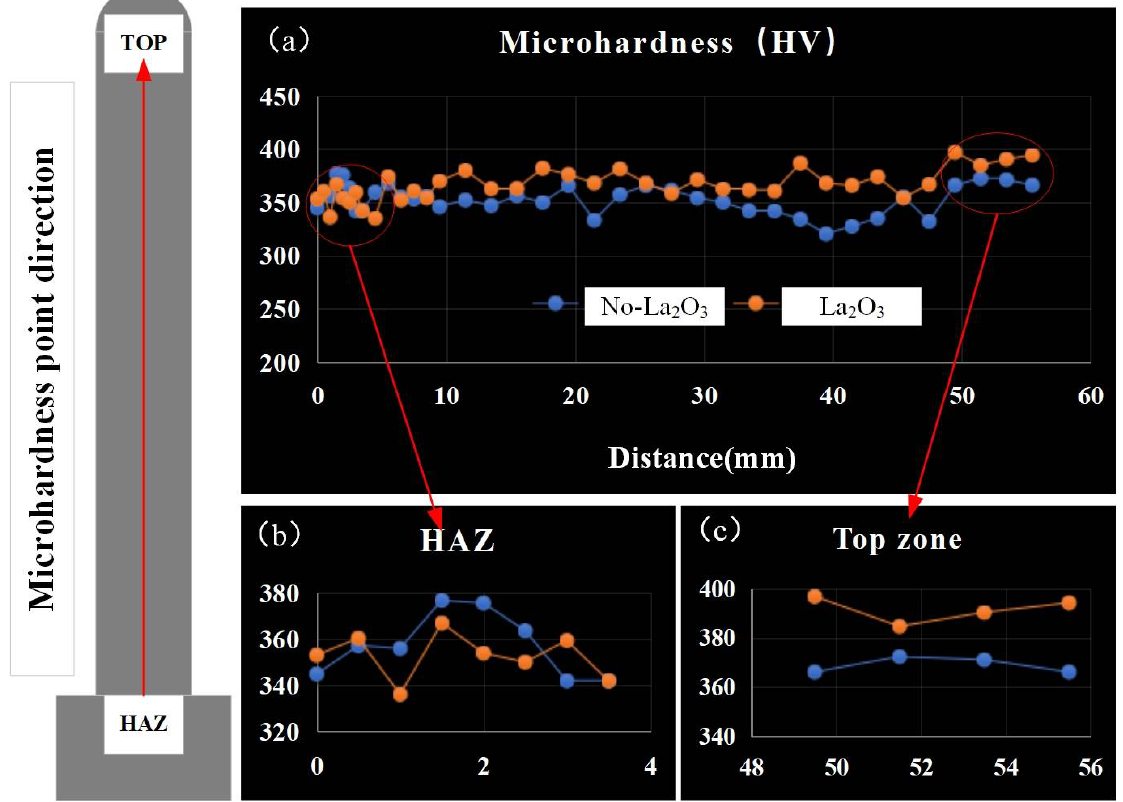
Figure 8. Microhardness distribution. ( a ) the microhardness of thin-walled parts, ( b ) the microhardness of HAZ and ( c ) the microhardness of top zone.